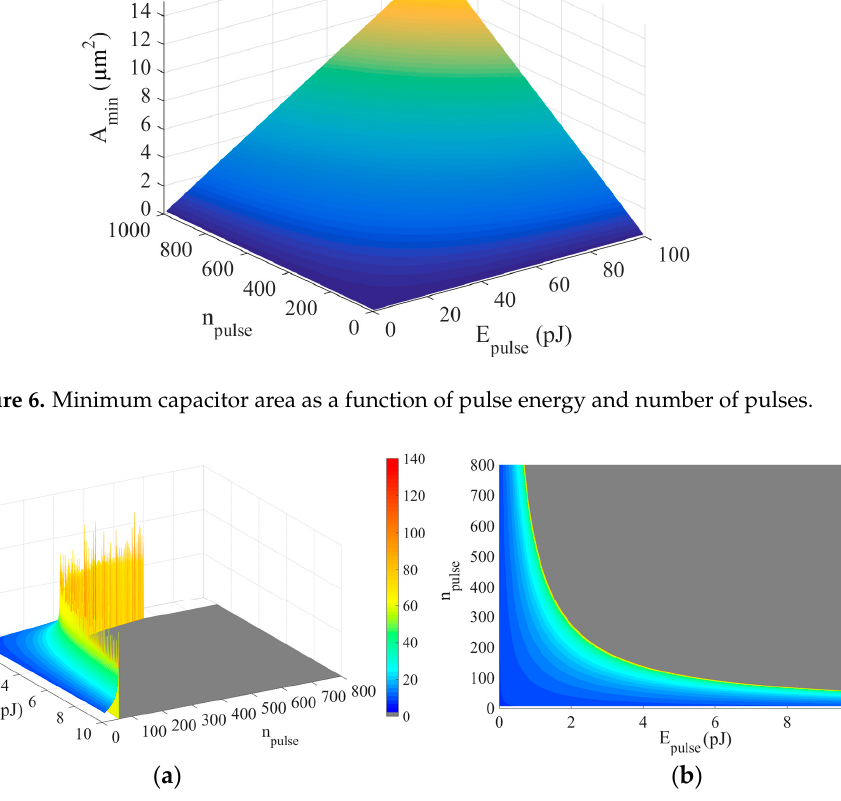
Figure 7. Charging time for different pulse energy and number of pulses ( a ). Same graph from top view ( b ).